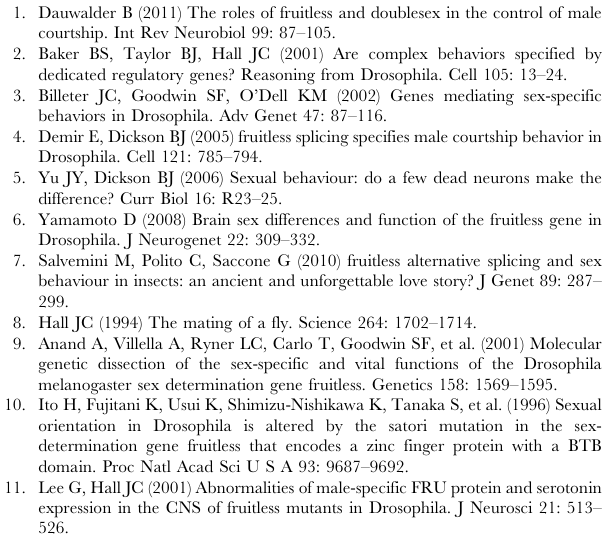
Table S3 Regulatory elements in the sex-specifically regulated region of fru homologs. Sequence of the putative Aeafru cis identified in the female-specific exon P1-f. The upper case indicate conserved nucleotides respect to the consensus sequences of Drosophila . The distance of these elements from the male- and female-specific 5 9 splicing donor sites are indicated. Table S4 Correspondence between MEME identified motifs and motif from RegRNA database. The nucleotides of MEME motifs corresponding to RegRNA motifs areshaded in light